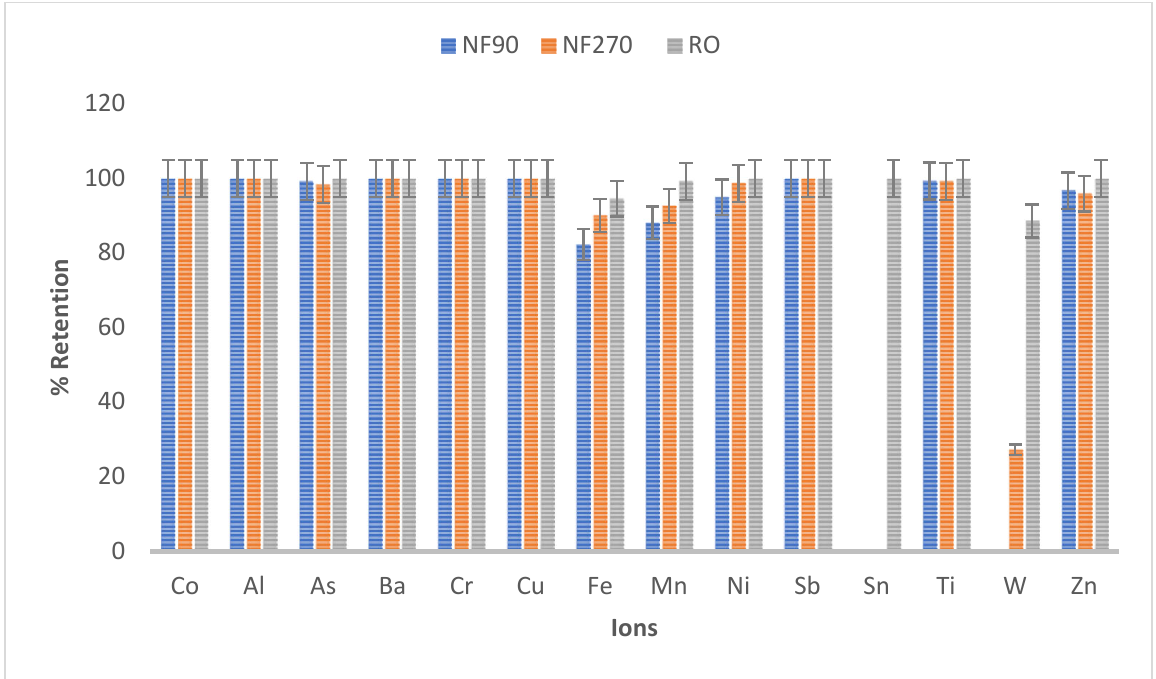
Figure 4. Retention of charged ions in real waters; analysis by ICP ‐ MS. The filtration of real wastewater with RO and NF eliminated the ion concentration to the WHO standard, as shown in Table 5. Table 5. Ion concentrations in permeate.